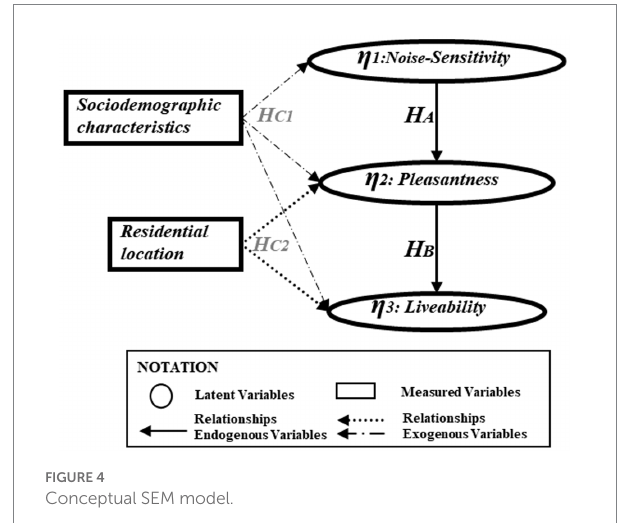
FIGURE 4 Conceptual SEM model.